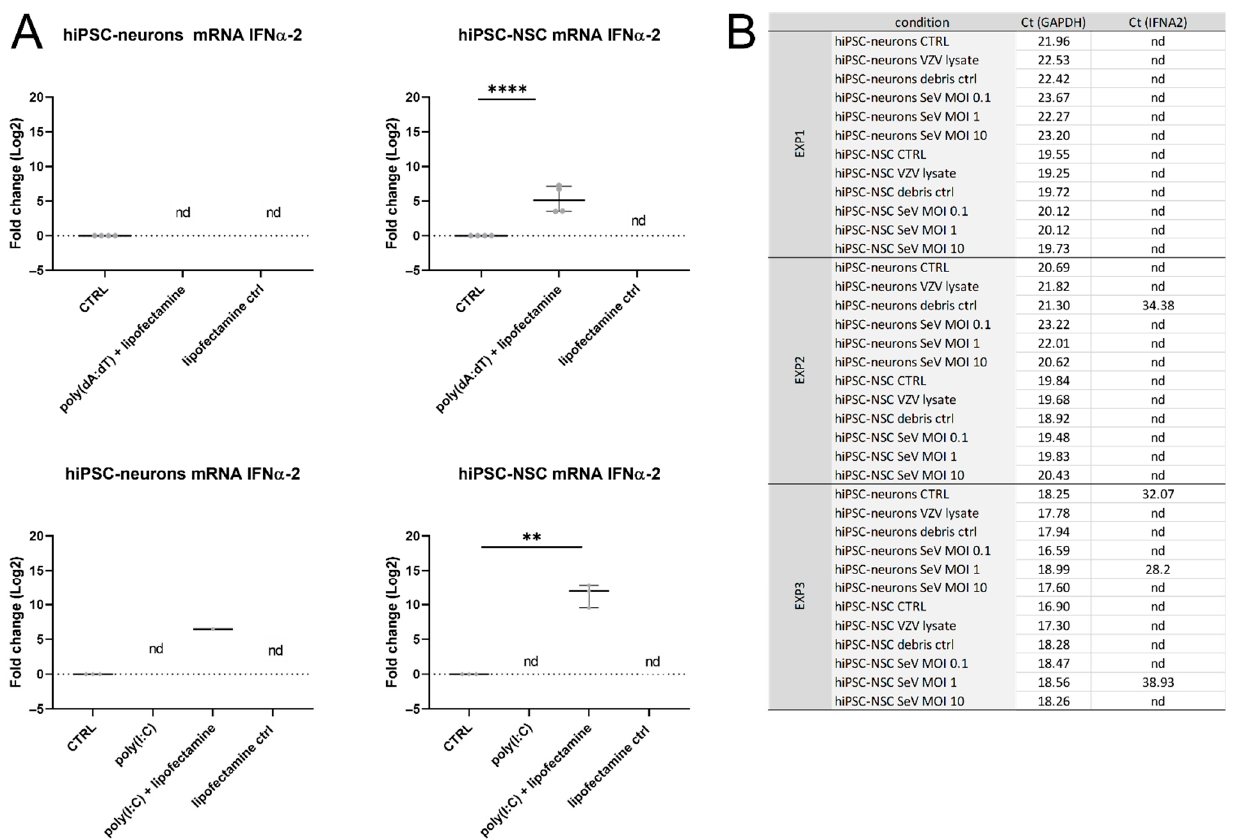
Figure 4. IFN α production is not detected in hiPSC neurons. ( A ) hiPSC-neurons do not produce detectable levels of IFN α -2 mRNA upon poly(dA:dT) or poly(I:C) stimulation. In contrast, in hiPSC- NSCs, IFN α -2 mRNA is significantly upregulated upon stimulation with poly(dA:dT) and poly(I:C) via transfection. Cell lysates were harvested at 24 h post stimulation and analyzed by RTqPCR. Transcript expression (log2) was set out relative to the mean of the untreated non-infected control group (CTRL), i.e., fold change. Each dot represents the log2 fold change of a single culture originating from one of four (poly(dA:dT) stimulation) or three (poly(I:C) stimulation) independent biological repeats. Lines with whiskers indicate the median with interquartile range. The p values were obtained from a paired t -test. ( B ) Raw Ct values for GAPDH (HKG) and IFN α -2 mRNA transcripts from each experiment are shown in the table. ** p < 0.01, **** p < 0.0001, nd: not detected.